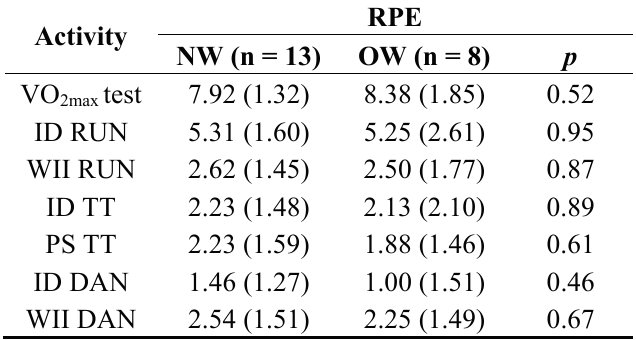
Table 5. Ratings of perceived exertion by weight status for each